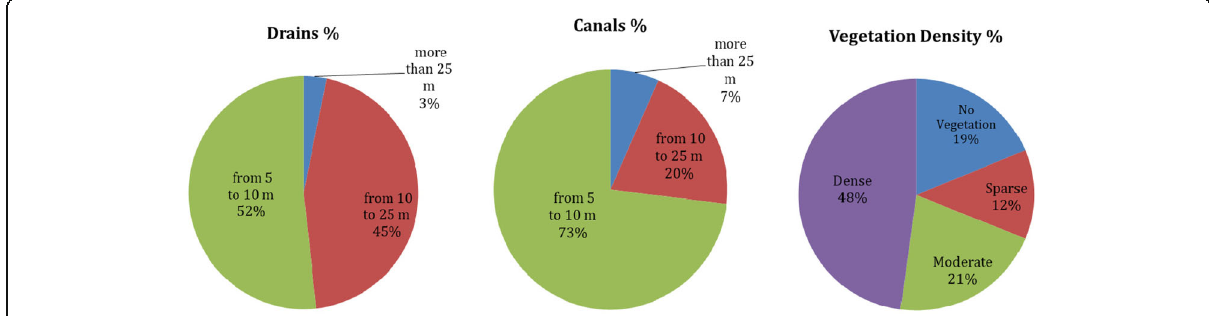
Fig. 3 Percentage of drainage network, irrigation canals and vegetation density in the study area